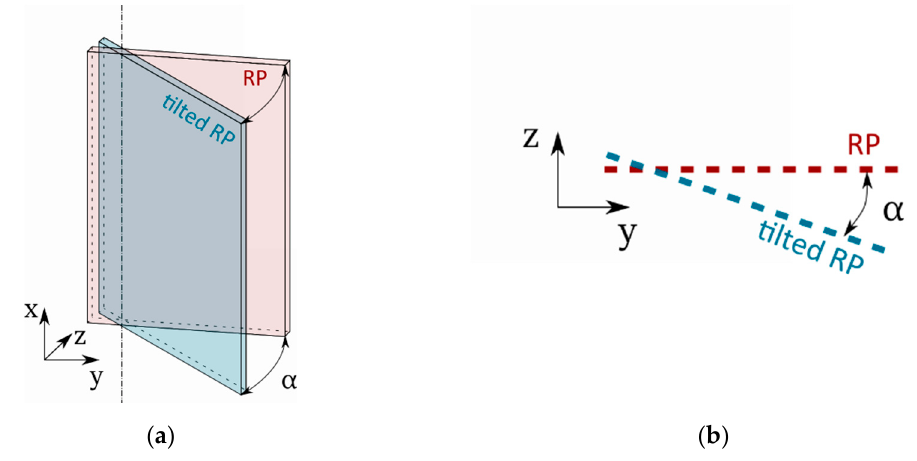
Figure 9. Scheme of the tilted RP: ( a ) three-dimensional (3D) view and ( b ) top view.